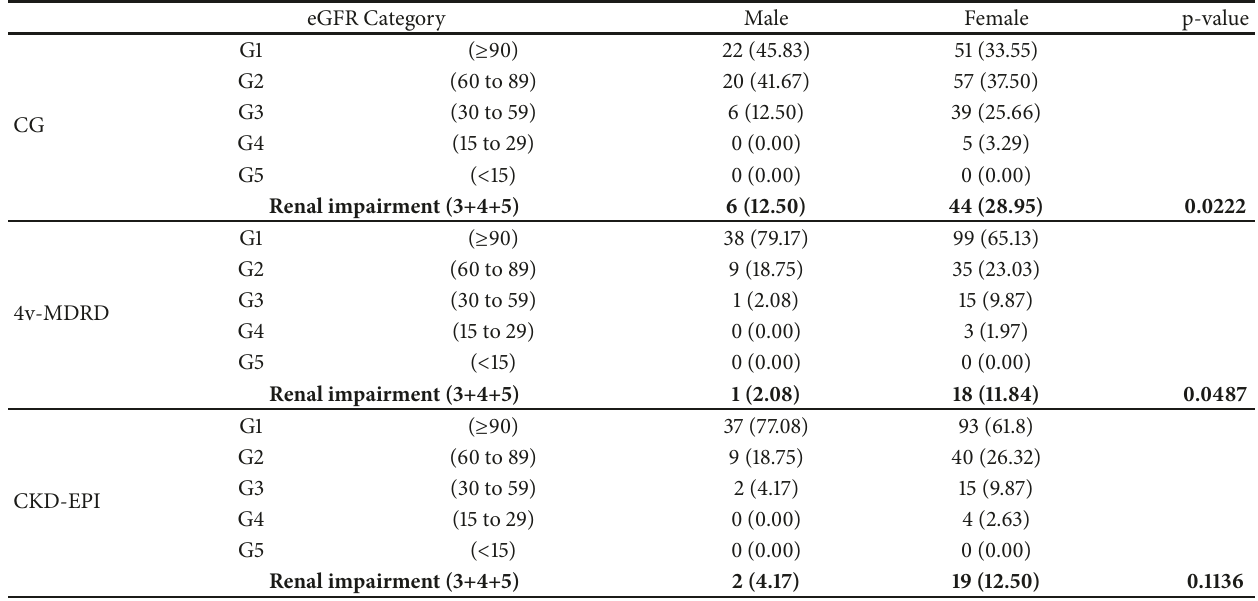
Table 5: Renal dysfunction categorization among study population using KDIGO eGFR Criteria stratified by gender.